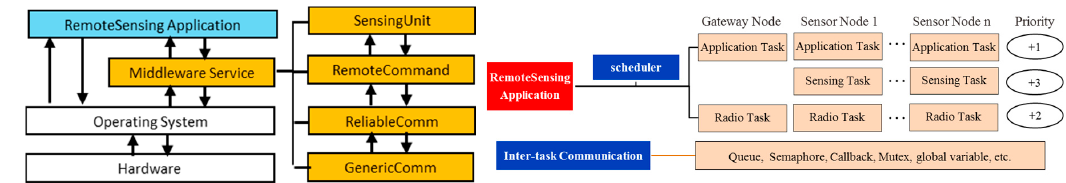
Figure 3. RemoteSensing application structure and its implementation in FreeRTOS.